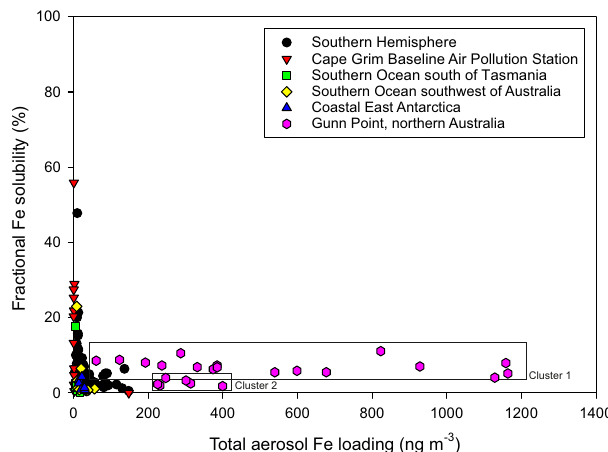
Figure 7. Gunn Point total PM 10 aerosol iron mass concentration versus fractional Fe solubility superimposed on the Southern Hemi- spheric aerosol iron data set (Sholkovitz et al., 2012, and references within; Bowie et al., 2009; Gao et al., 2013; Winton et al., 2015a). Boxes highlight the two clusters. Cluster 1: moderate fractional Fe solubility and moderate total aerosol iron loading between 4 and 19 June. This cluster represents the upper bound of dust fractional Fe solubility of mixed mineral dust and biomass-burning-derived particles in the topical dry season. Cluster 2: low fractional Fe sol- ubility and low total aerosol iron loading between 24 and 26 June, i.e. intense proximal biomass burning.